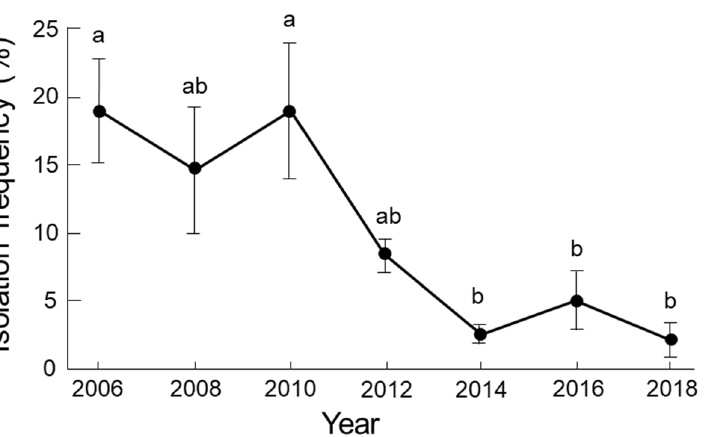
Figure 6. Changes of isolation frequency for the total population of Globisporangium spp. from a single colony of Sanionia moss in Ny-Ålesund, Spitsbergen Is., Norway from 2006 to 2018. The investigations were conducted in August each year. Isolation frequency was calculated as the number of moss shoots with isolated Globisporangium spp. divided by the total number of moss shoots examined. The average values with SE ( N = 6) were shown. Values followed by the same letter are not significantly different according to Tukey’s HSD test ( p < 0.05).